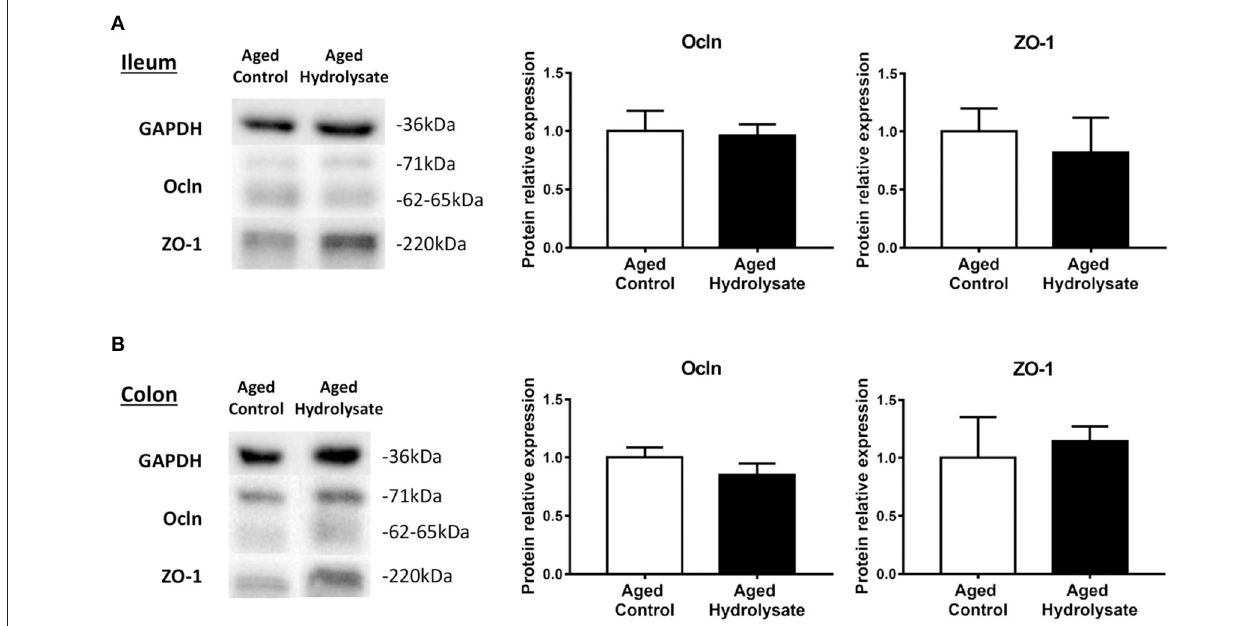
FIGURE 10 | Effects of the fish hydrolysate supplementation on protein expression of intestinal permeability markers. Intestinal permeability markers ocln and ZO-1 protein expressions in (A) the ileum and (B) the colon of aged mice fed with the control diet or the hydrolysate-enriched diet for 10 weeks. n = 8 per group. Data are presented as mean ±